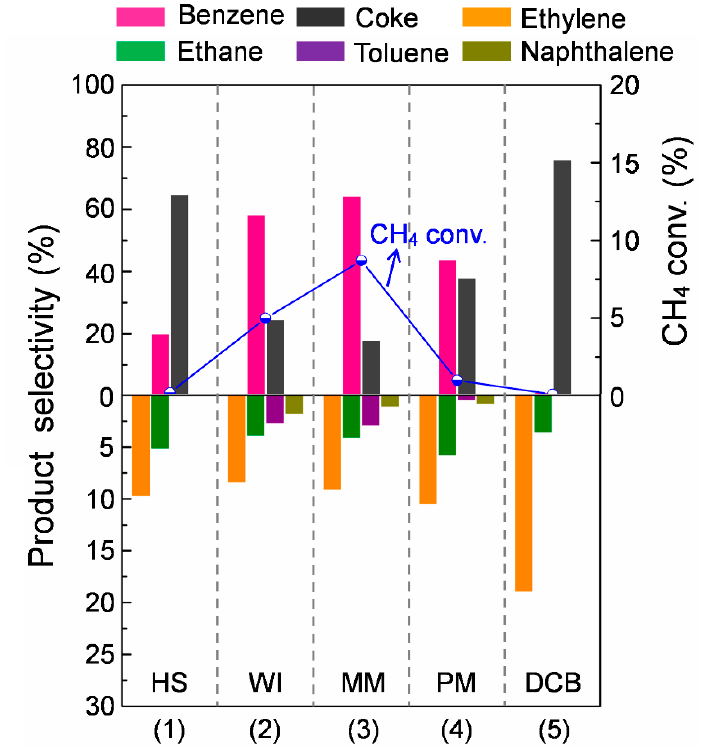
Figure 8. MDA performance of the Mo/HMCM-22 catalysts. (1) Mo/HMCM-22-HS; (2) Mo/HMCM-22-WI; (3) Mo/HMCM-22-MM; (4) Mo/HMCM-22-PM and (5) Mo/HMCM-22-DCB. They are also abbreviated as HS, WI, MM, PM, and DCB in the figure, respectively. Reaction condition: temperature, 700 °C; pressure, 1 atm; CH 4 /Ar = 9/1; flow rate, 12.5 mL min − 1 ; catalyst weight, 0.5 g; and time on stream, 6 h.